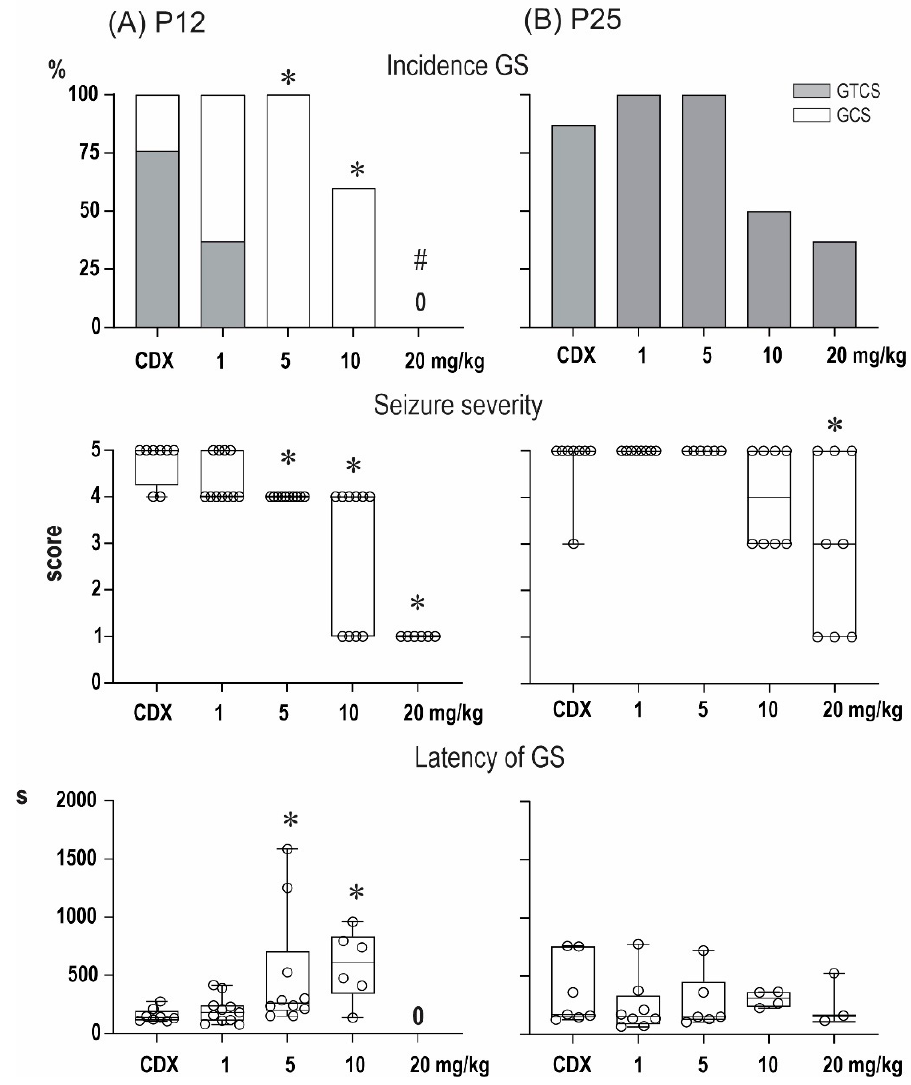
Figure 2. Effect of pregnanolone sulfate (PA-S) on seizures induced by pentylenetetrazol in 12- ( A ) and 25-day-old rats ( B ). From top to bottom: the incidence of generalized seizures (GS) is shown in columns (the black parts indicate complete generalized tonic-clonic seizures; the white parts show generalized clonic seizures without the tonic phase). The severity of seizures is expressed as a score [20], and the latencies of generalized seizures are shown as box plots (min to max) with individual values (circles). # denotes a significant difference in the incidence of GS compared with the controls, * denotes a significant difference in the incidence of TF in seizure severity and GS latency compared with the controls, and 0 means that none of the rats in the group exhibited GS.